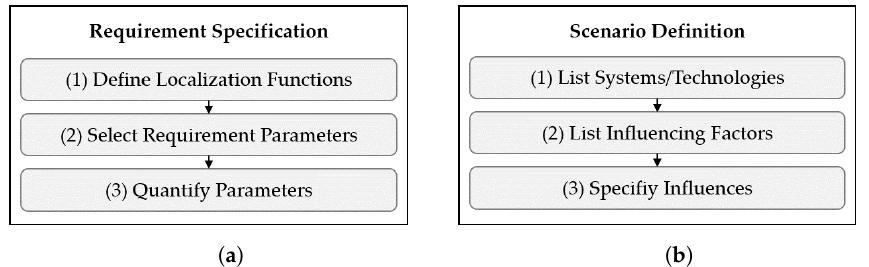
Figure 5. Functions of the module Requirement Specification ( a ) and Scenario Definition ( b ).